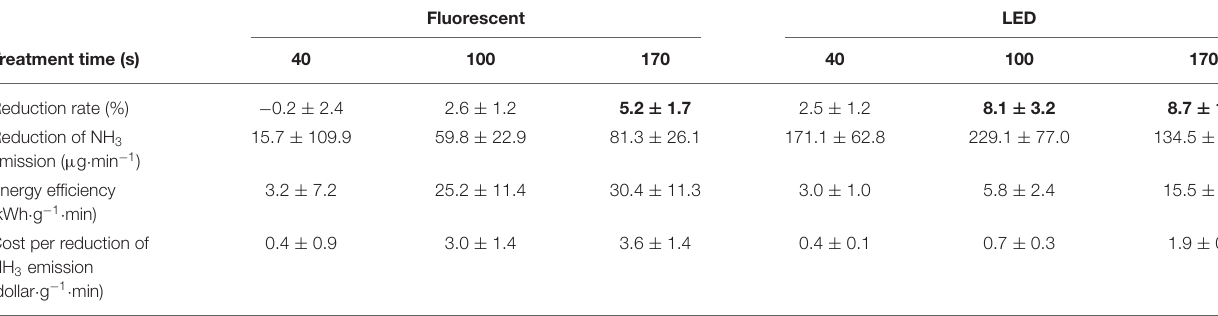
TABLE 9 | Economic analysis of NH 3 .